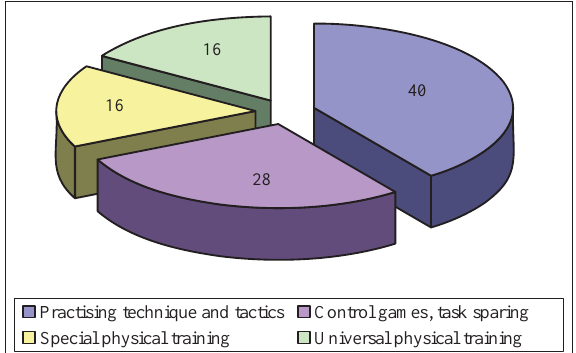
Fig. 3. Proportions of training means in the intensifi cation phase, %